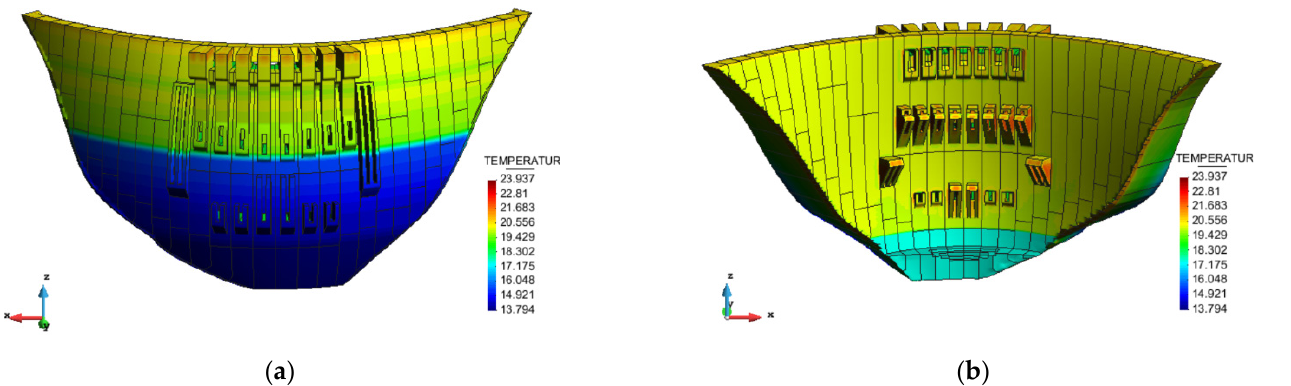
Figure 18. Cloud map of quasi-stable temperature field distribution of the dam in November (unit: °C). ( a ) Upstream face; ( b ) Downstream surface.